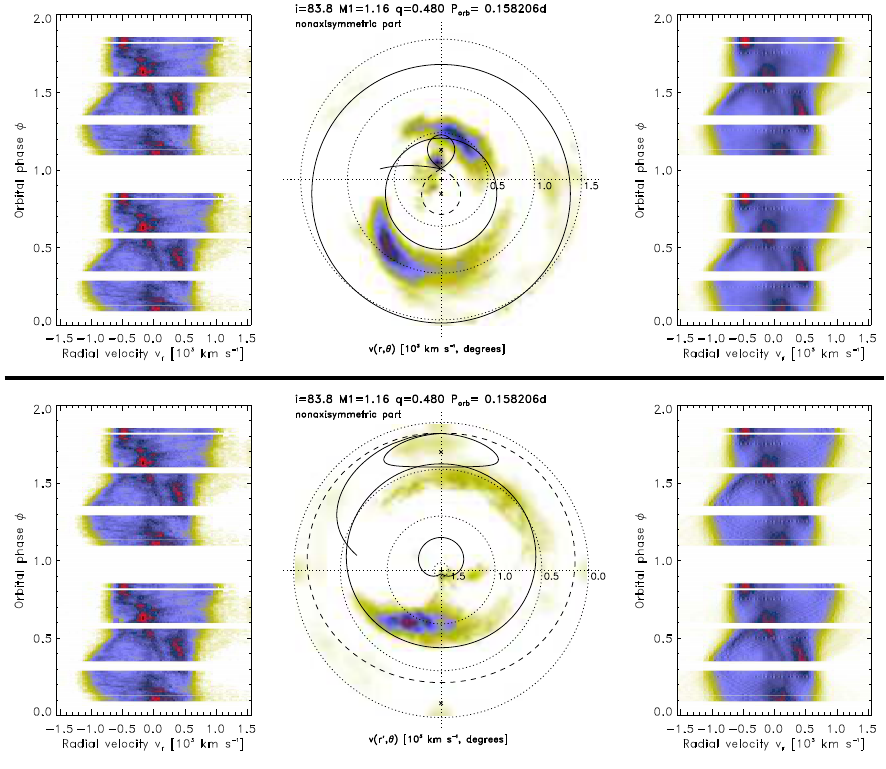
Figure 3: Doppler tomography of IP Peg. Normal (top) and inside-out (bottom) tomograms are shown for comparison. The input and reconstructed trailed spectra are shown in the left and right panels, respectively.